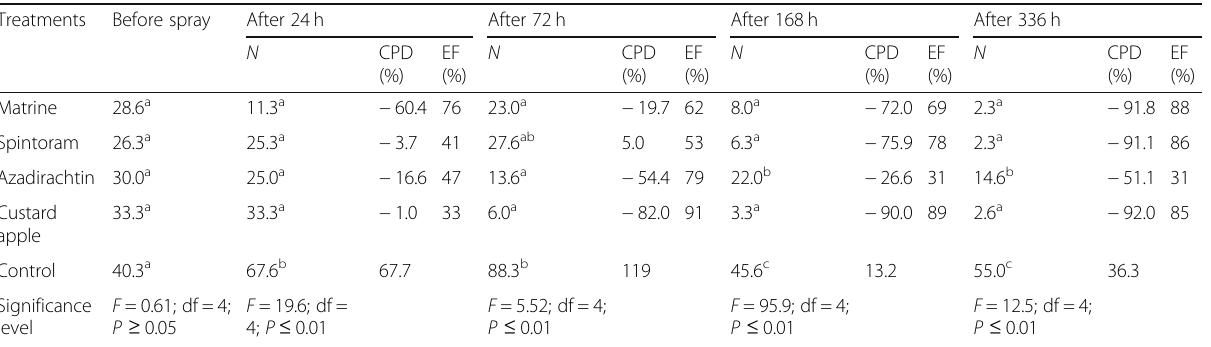
Table 2 Population densities of Tetranychus urticae ( N ) on hydroponic cucumber and effectiveness of biopesticides Treatments